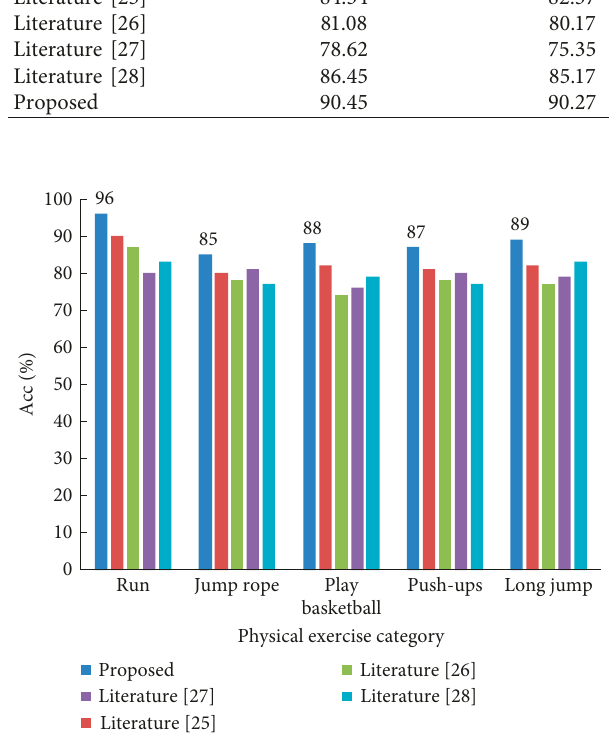
Figure 4: Comparison of prediction accuracy of different types of